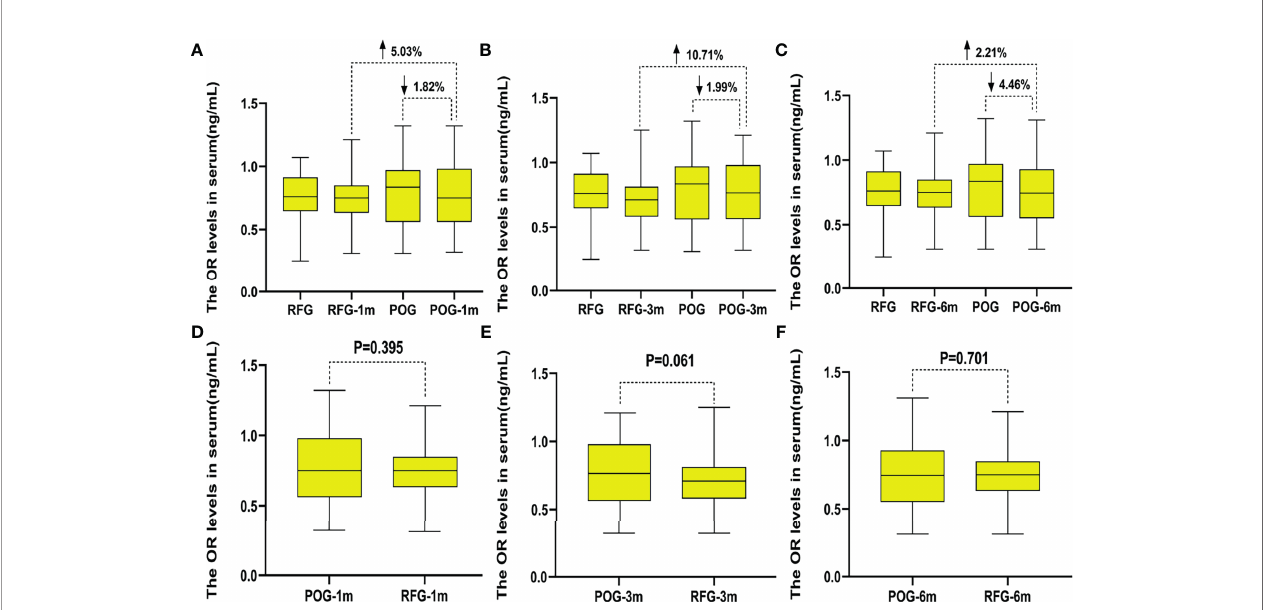
FIGURE 3 | The changes of ovarian arterial resistance index (OARI) in the two groups. Compared with preoperative, the decline rate of OARI in postoperative observation group (POG) of ovary cyst side after the fi rst postoperative month was 1.82%. Compared with the OARI of referent group (RFG) in the same ovary side, the increased rate of OARI in POG of ovary cyst side after the fi rst postoperative month was 5.03% (A) . Compared with preoperative, the decline rate of OARI in POG of ovary cyst side after third postoperative month was 1.99%. Compared with the OARI of RFG in the same side ovary, the increased rate of OARI in POG in the ovary cyst side after the third postoperative month was 10.71% (B) . Compared with preoperative, the decline rate of OARI in POG of ovary cyst side after the sixth postoperative month was 4.46%. Compared with the OARI of RFG in the ovary cyst side, the increased rate of OARI in POG in the ovary cyst side after the third postoperative month was 2.21% (C) . The OARI of the cyst side showed no signi fi cant difference in POG when compared with that in RFG in the same side ovary postoperatively in the fi rst, third, and sixth month (p = 0.395, p = 0.061, p = 0.701) (D – F) .